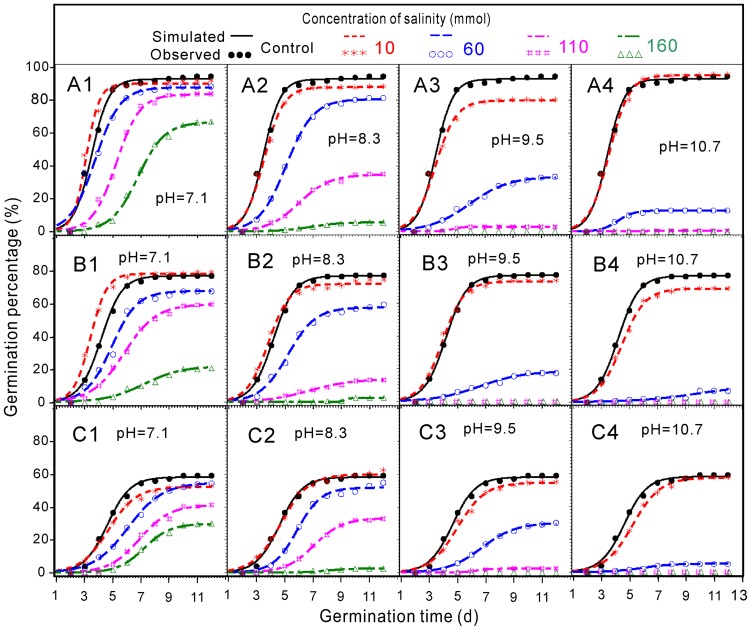
Simulated logistical curves showed the dynamic germination percentages under mixed salt-alkaline stress.A, B and C represent the cultivars, Blackwell, Cave-In-Rock and Kanlow switchgrass, respectively. All the logistic models were significant at Pr<0.0001.